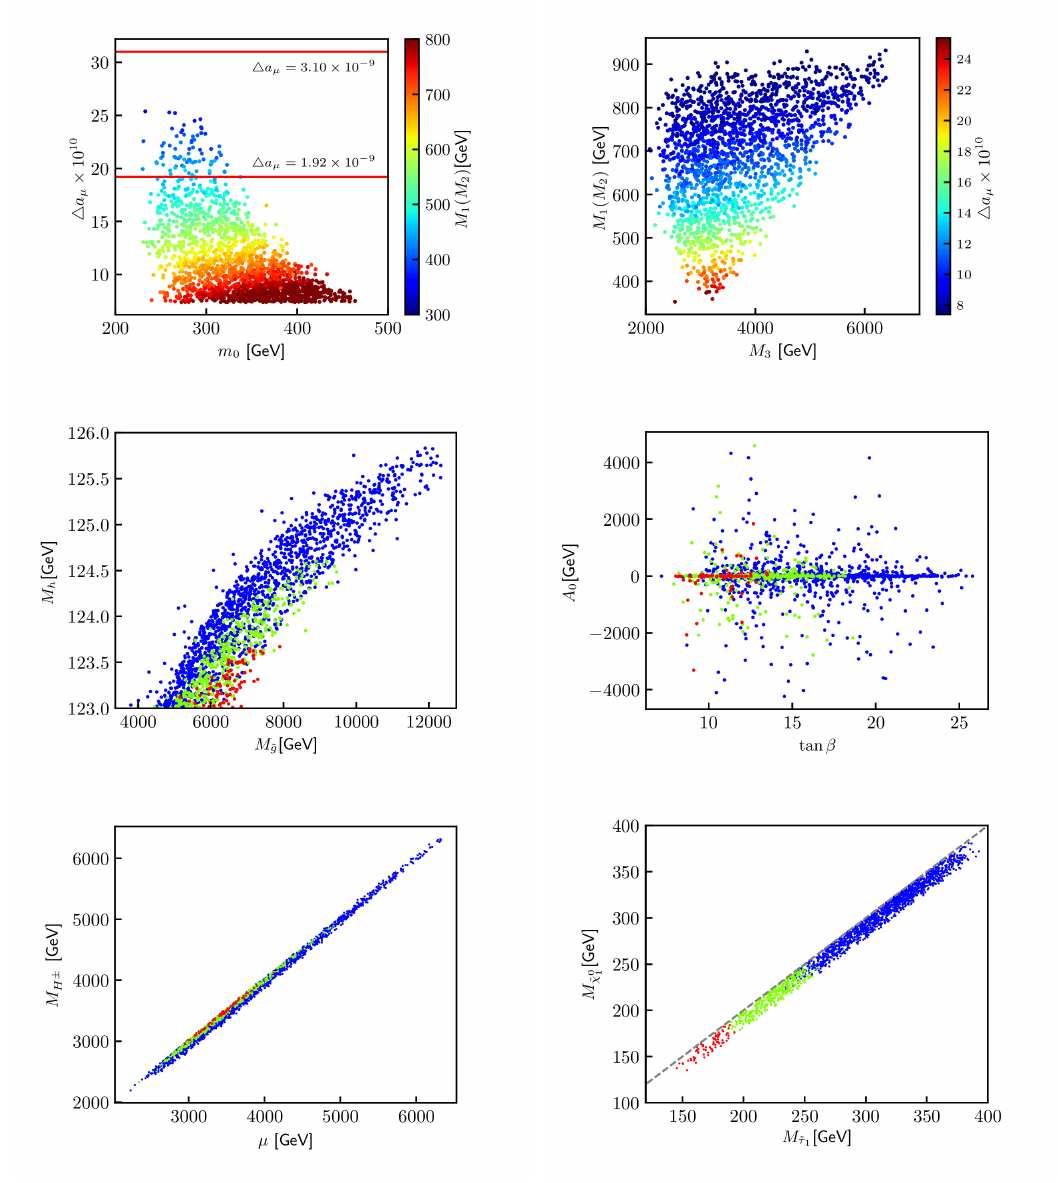
Figure 2 . Survived points in scenario (1) that can satisfy the constraints (i-vi) and give SUSY contributions to ∆ a up to the 1 σ range of ∆ a combine . In the middle and lower panels, the red, µ µ green and blue points denote the survived samples that can give ∆ a SUSY up to the 1 σ , 2 σ and 3 σ µ levels,